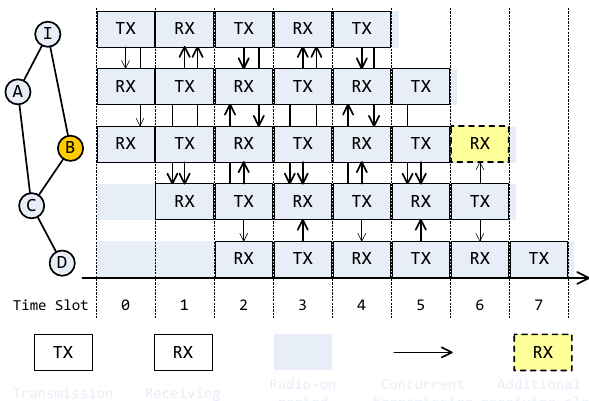
Figure 3. Time slots in one round of LiM with a configuration of N = 3. A data packet is generated in and flowed from node I to all the others. LiM compels node B to extend one extra listening time slot for the exploring feedback, particularly for receiving the feedback from downside